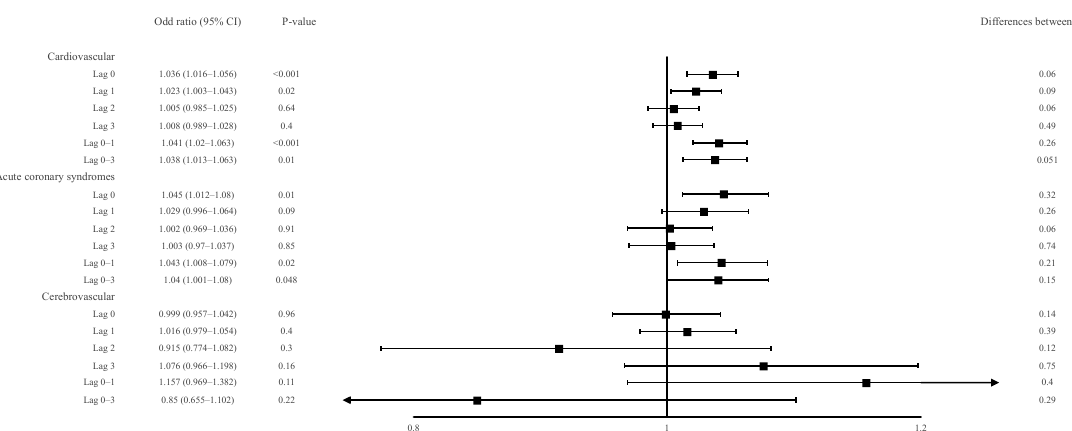
Atmosphere 2021 , 12 , x FOR PEER REVIEW Figure 2. Meta-analysis results for the associations between the exposure to short-term particulate matter with a diameter of 2.5 µ m or less and cardiovascular-, acute coronary syndrome-, and cerebrovascular-related mortality.